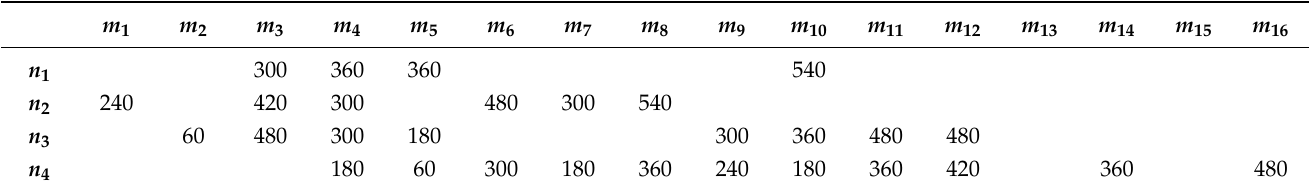
Table 13. Distance travelled for Variant #1